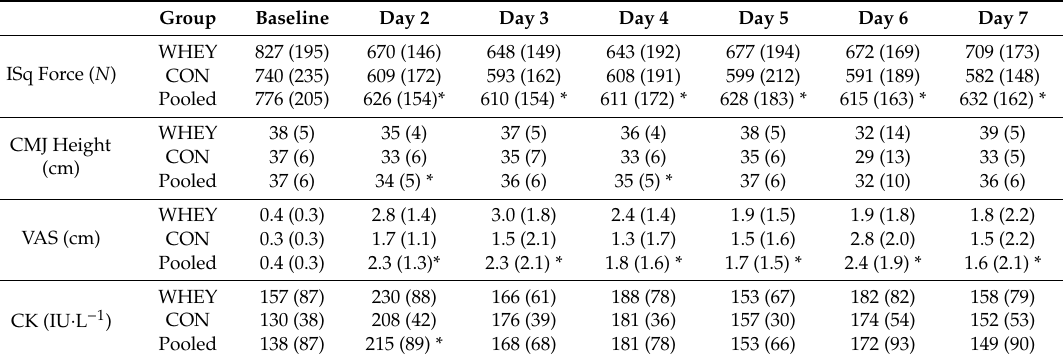
Table A4. Recovery